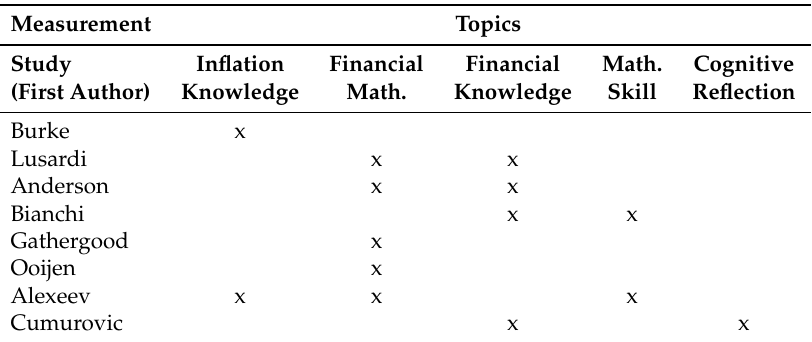
Table 2. Content of financial literacy